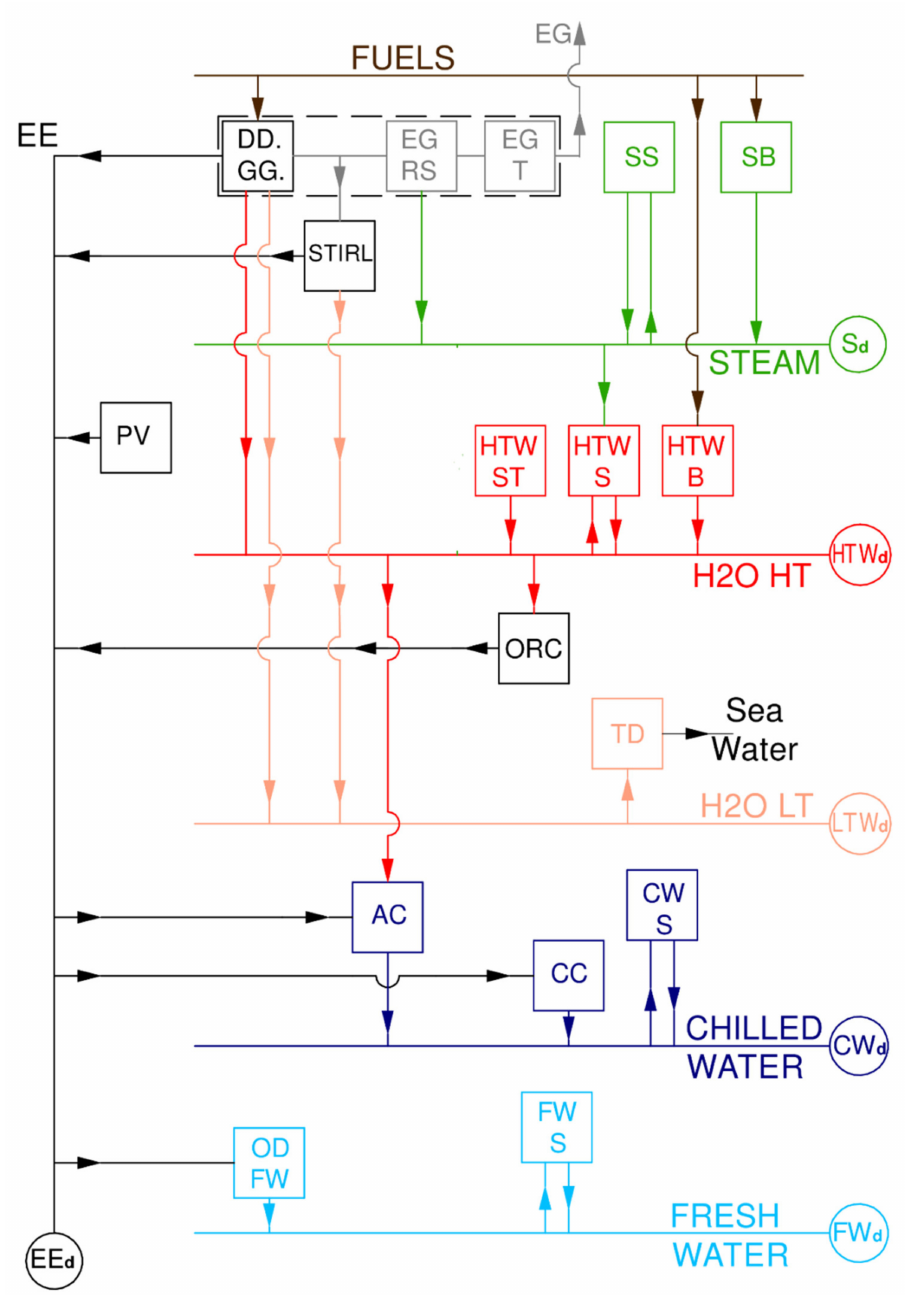
Figure 5. Super-structure of the on board energy